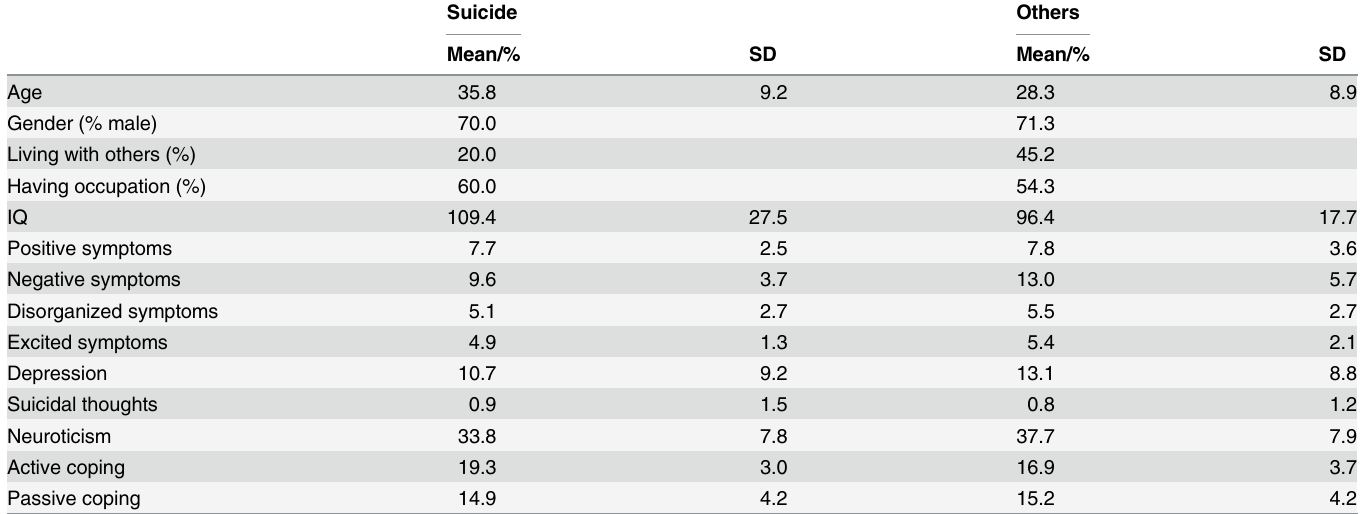
Table 1. Overview of potential predictors of suicide for the suicide group and the other patients from the original dataset.